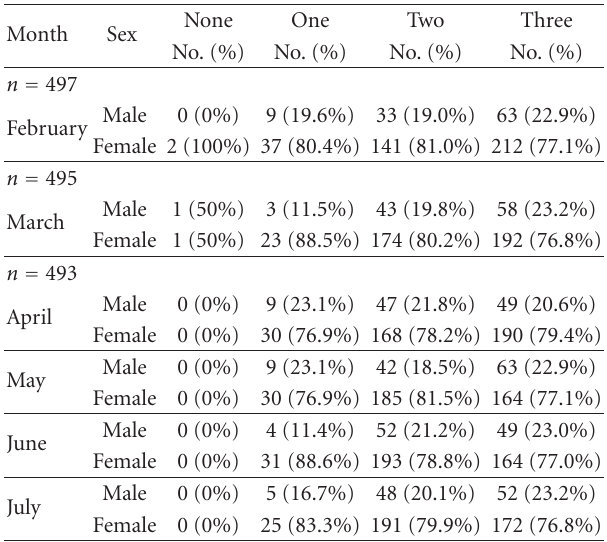
Table 1: Distribution of HIV seropositive patients by frequency of meals and